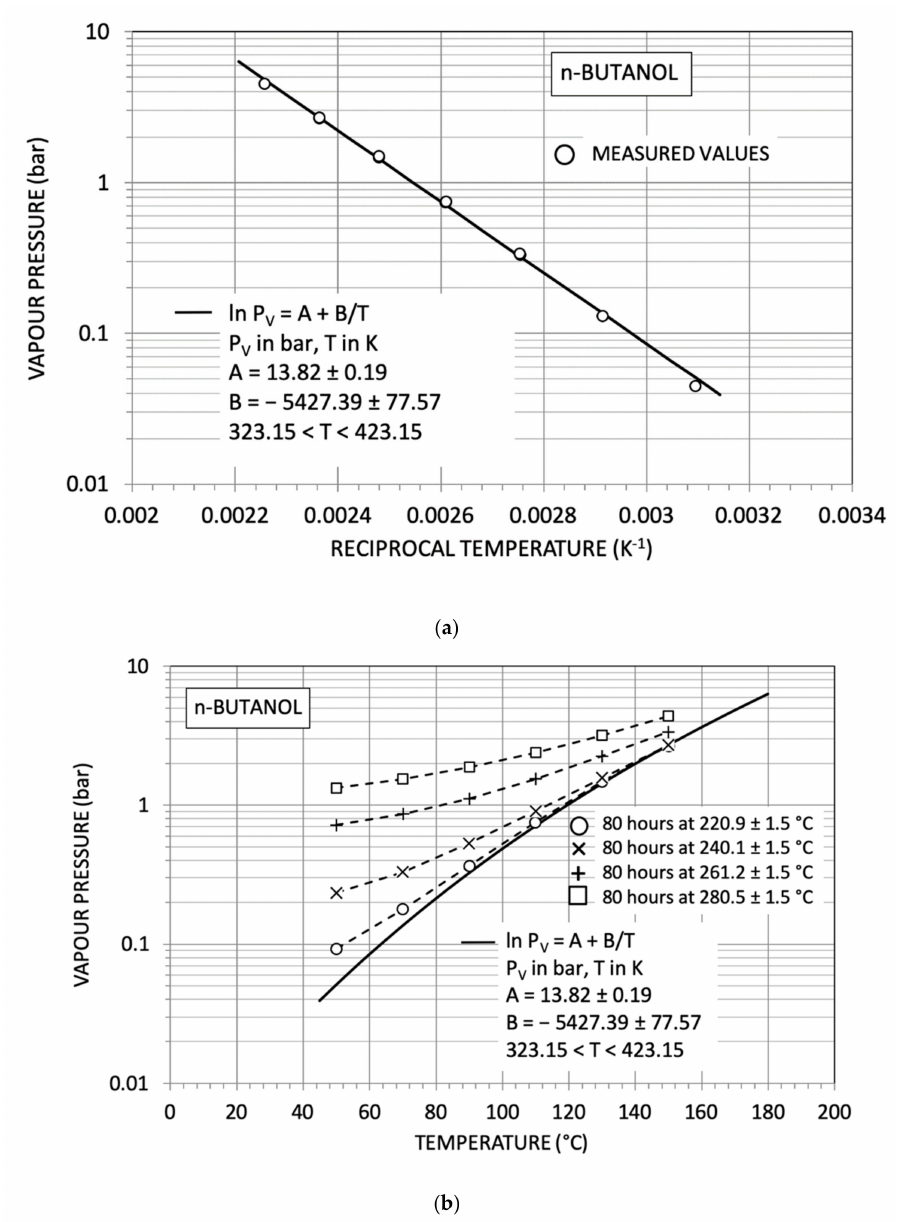
Figure 12. Thermal stability test for n-butanol: ( a ) reference vapour pressure (virgin fluid), ( b ) vapour pressure profile after di ff erent thermal stress